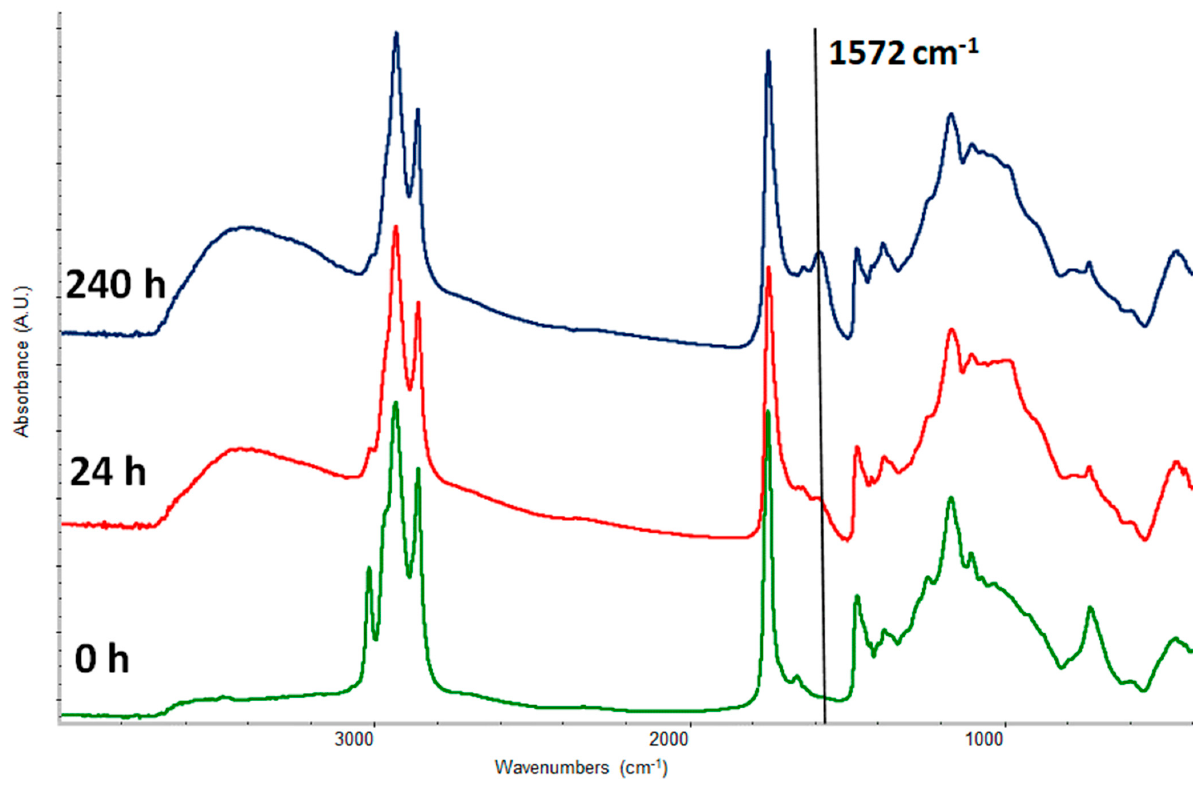
Figure 1. Kinetics of smalt carboxylate formation from a mixture 1:1 ( w / w ) of stand oil and smalt. The black arrow shows the carboxylate band. Table 1. Table reports the position (in wavenumbers, cm − 1 ) and the assignments of the main bands of linseed oil, colophony, palmitic acid and abietic